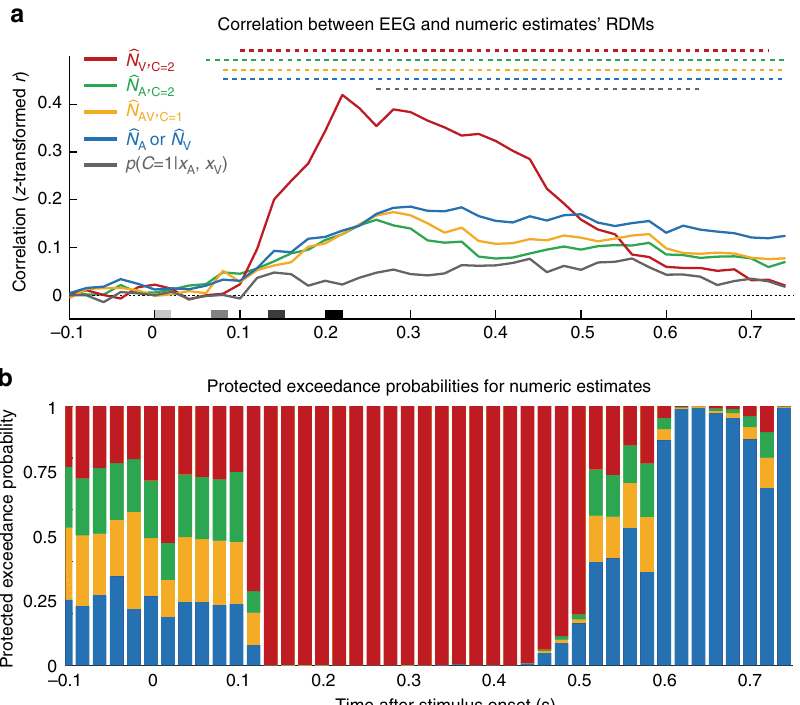
Fig. 4 Correlation of the representational dissimilarity matrices (RDMs) of EEG activity patterns with the BCI model ’ s estimates and their exceedance probability. a Spearman ’ s rank correlation coef fi cients (across-participants mean of Fisher ’ s z -transformed r ; n = 23) as a function of time. The correlation coef fi cients were computed between the RDMs of EEG activity patterns of all 64 electrodes and the RDMs of the BCI model ’ s internal estimates: i. the unisensory visual ( ^ N , red), ii. the unisensory auditory ( ^ N , green) estimates under the assumption of independent causes ( C = 2), iii. the forced- V ; C ¼ 2 A ; C ¼ 2 fusion estimate ( ^ N , yellow) under the assumption of a common cause ( C = 1) and iv. the fi nal BCI estimate ( ^ N or ^ N , depending on the task-relevant AV ; C ¼ 1 A V sensory modality, blue) that averages the task-relevant unisensory and the forced-fusion estimate by the posterior probability estimate of each causal ð Þð Þ . Color-coded horizontal dashed lines indicate clusters of signi fi cant correlation coef fi cients ( p < 0.05; one-sided cluster-based ; x structure p C ¼ 1 j x A V corrected randomization t 22 test). Stimulus onsets are shown along the x axis. b To identify which of the four numeric BCI estimates is most likely represented in the EEG activity patterns, we computed the protected exceedance probability (i.e. the probability that a given estimate is more likely encoded in the EEG activity patterns than any other estimate, beyond differences due to chance) for each of the four numeric BCI estimates as a function of time. The length of an estimate ’ s bar indicates the estimate ’ s protected exceedance probability (n.b.: the y axis indicates protected exceedance probabilities cumulated over the BCI estimates). Source data are provided as a Source Data fi